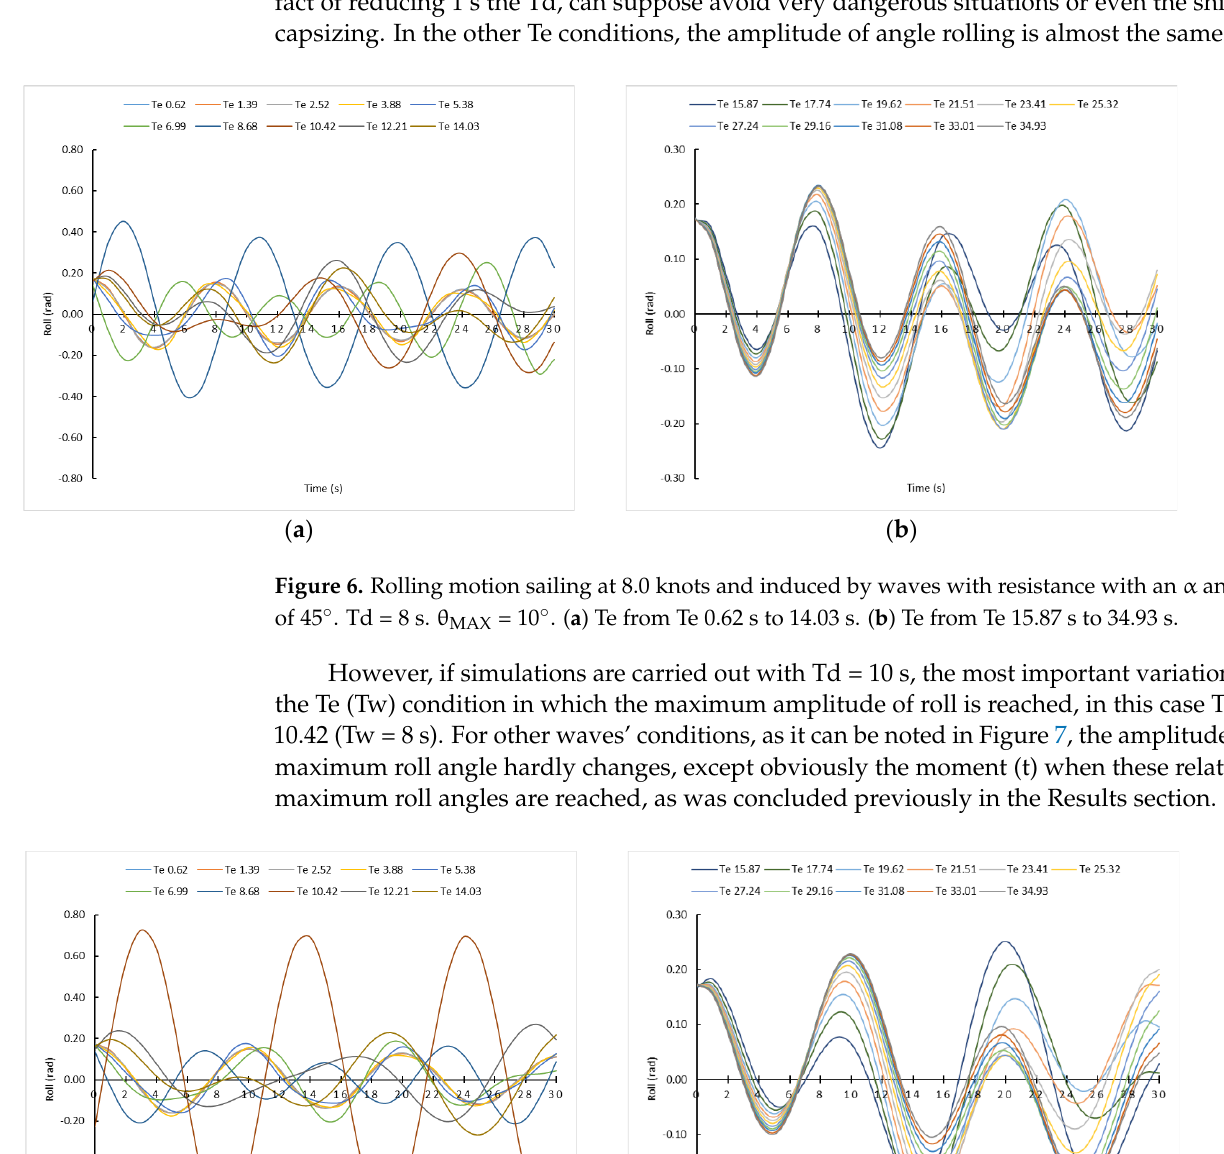
Figure 7. Rolling motion sailing at 8.0 knots and induced by waves with resistance with an α angle of 45°. Td = 10 s. θ MAX = 10°. ( a ) Te from Te 0.62 s to 14.03 s. ( b ) Te from Te 15.87 s to 34.93 s.